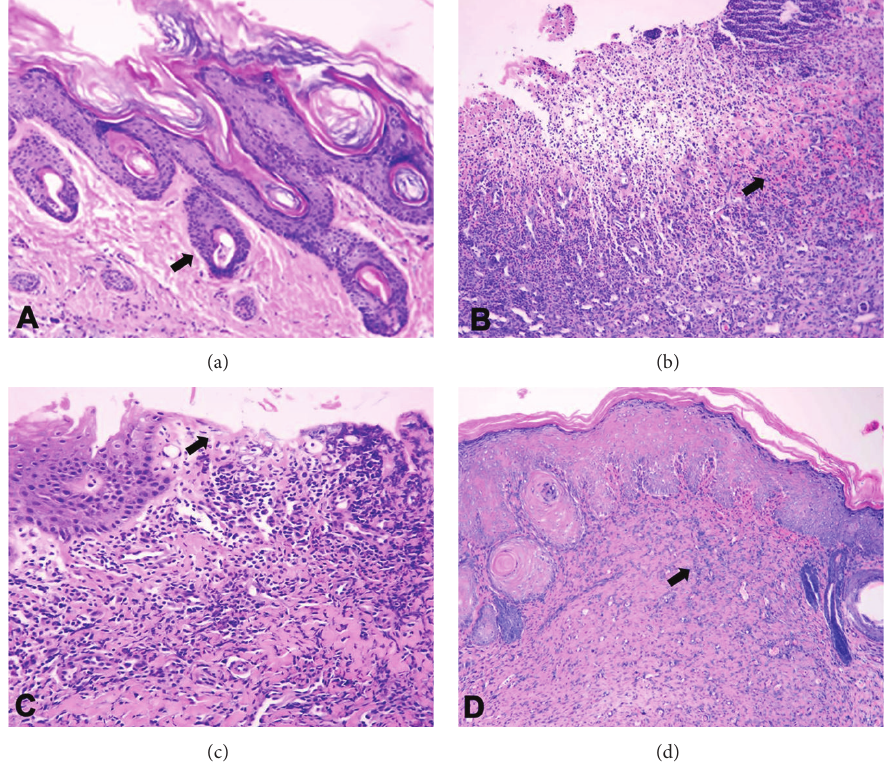
Figure 3: Results of microscopic observation. (a–d): these were the photomicrographs of the skin of each group of nerve injury diabetic foot on day 28. (a) The DC group showed clear skin structure (arrow). (b) The DNIM group showed serious injury and forming ulcer (arrow) deep to the layer of hypodermis. (c) The JWH Group showed the healing ulcer with the regeneration of epidermis (arrow). (d) The rhEGF Group showed the healed ulcer with scarring under the epidermis (arrow) (HE 40x).